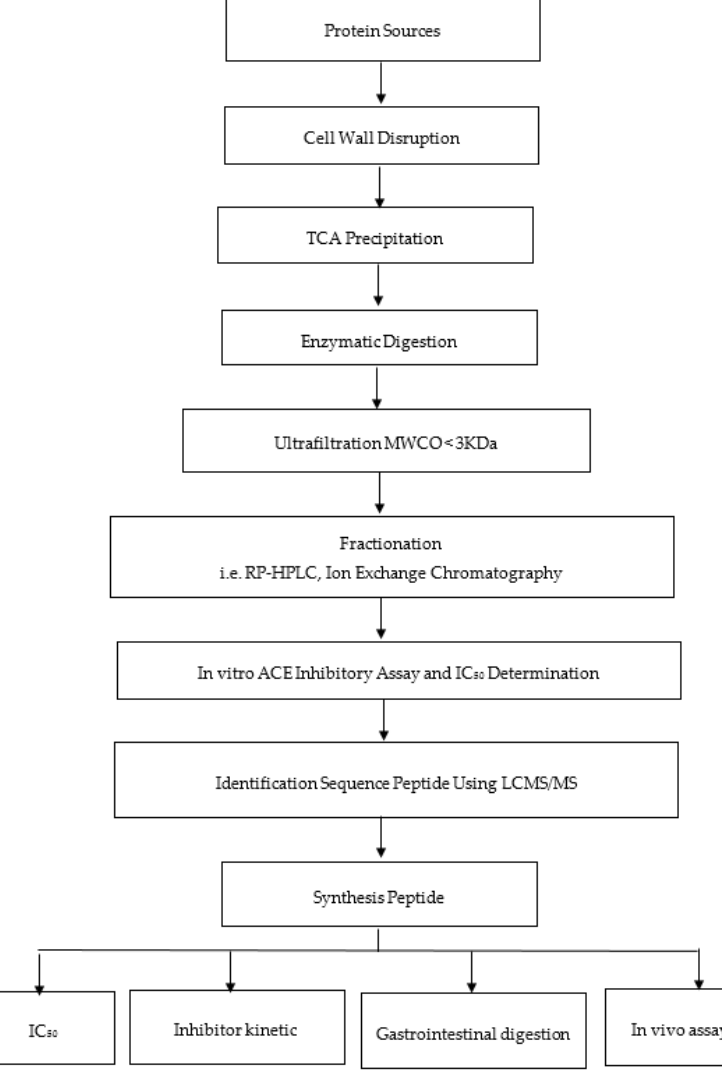
Figure 2. Flowchart showing the production of bioactive peptides for angiotensin I-converting enzyme (ACE) inhibitory assay [25].